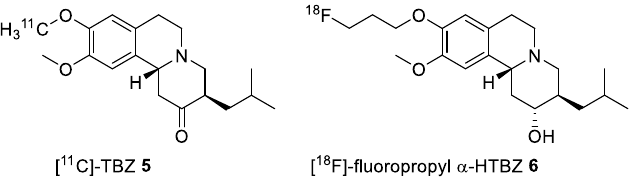
Figure 4. TBZ-based positron emission tomography (PET) imaging agents.